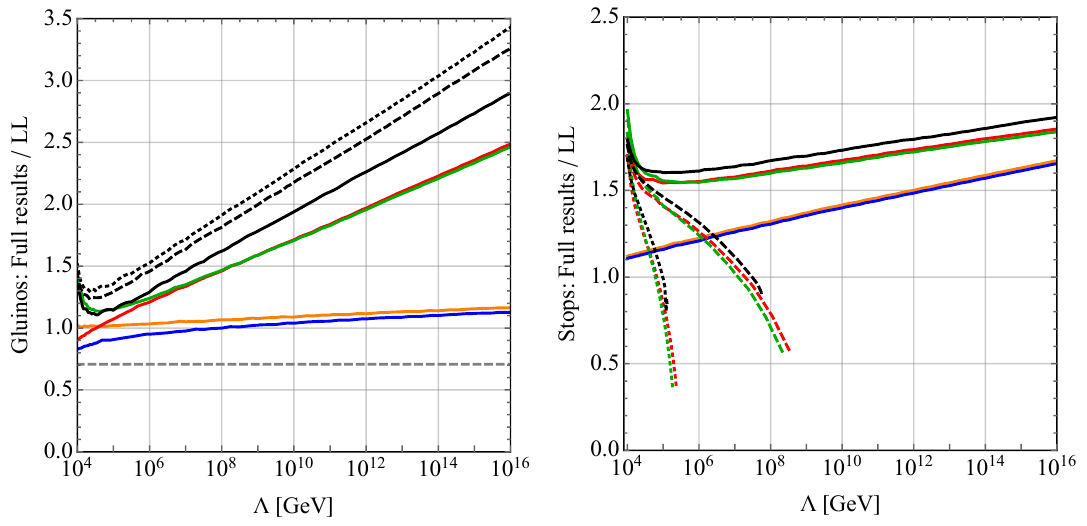
Figure 9 . The ratio of the (cid:1) = 10 naturalness bound on the gluino (left) and stop (right) masses, with the higher-order e(cid:11)ects outlined in this paper sequentially added, to the same naturalness bound in the LL approximation (with the couplings evaluated at Q = 1 TeV). The successively included e(cid:11)ects are: resummed one-loop RGEs (orange), resummed two-loop RGEs (blue), IR running masses (red), two-loop threshold corrections to m 2 (green), and (cid:12)nally moving converting H u the IR running mass to the pole mass (black). First and second generation squarks are varied between being degenerate with 3rd generation (solid), or at 5 TeV (dashed) and 10 TeV (dotted). The dashed horizontal line for the gluino is the LL result of [11], with a numerical error resulting p in a 2